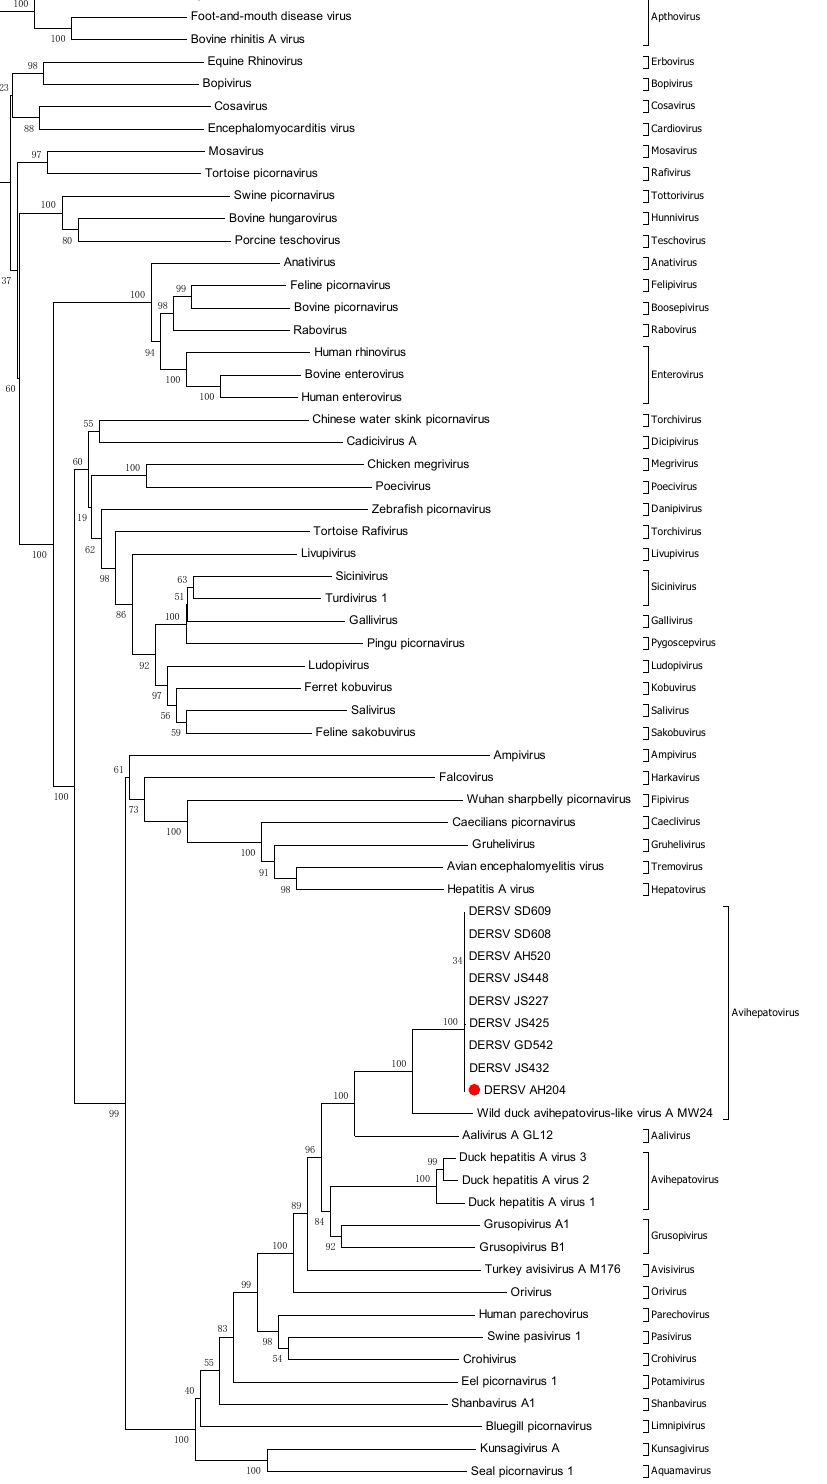
Figure 1. Phylogenetic relationship between DERSV and other picornaviruses. The neighbor-joining tree was constructed according to the amino acid sequences of DERSV (AH204 strain). The numbers along the branches mark the bootstrap values percentage out of 1000 bootstrap resamplings. The scale bar indicates the number of substitutions per